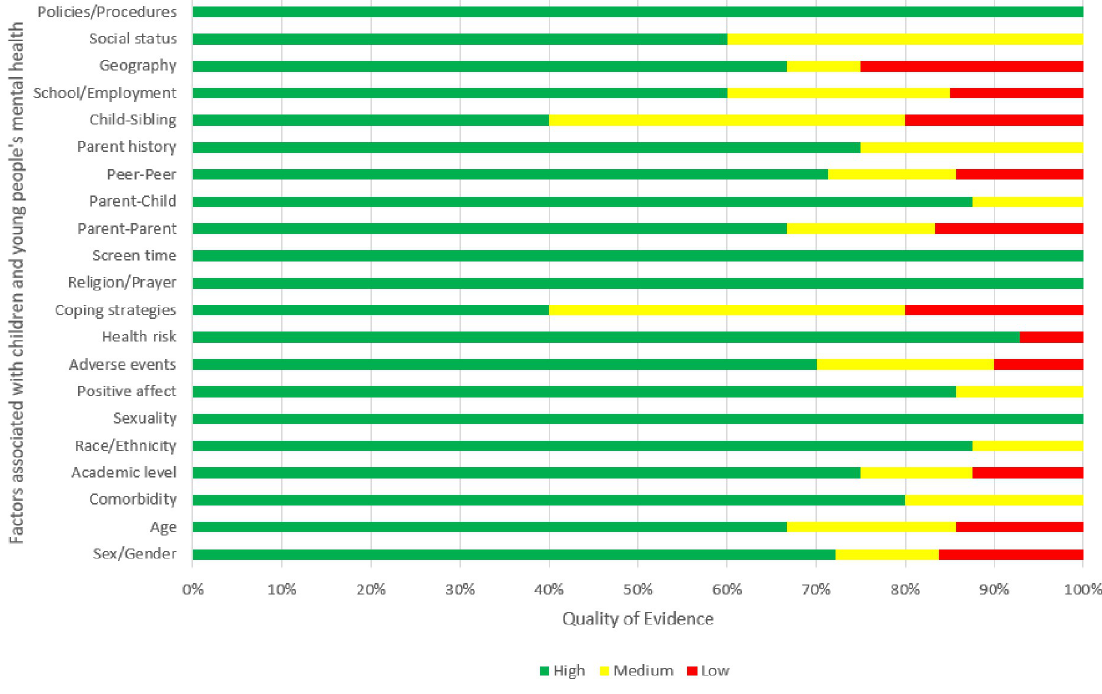
Fig 3. Summary of the quality of evidence for each